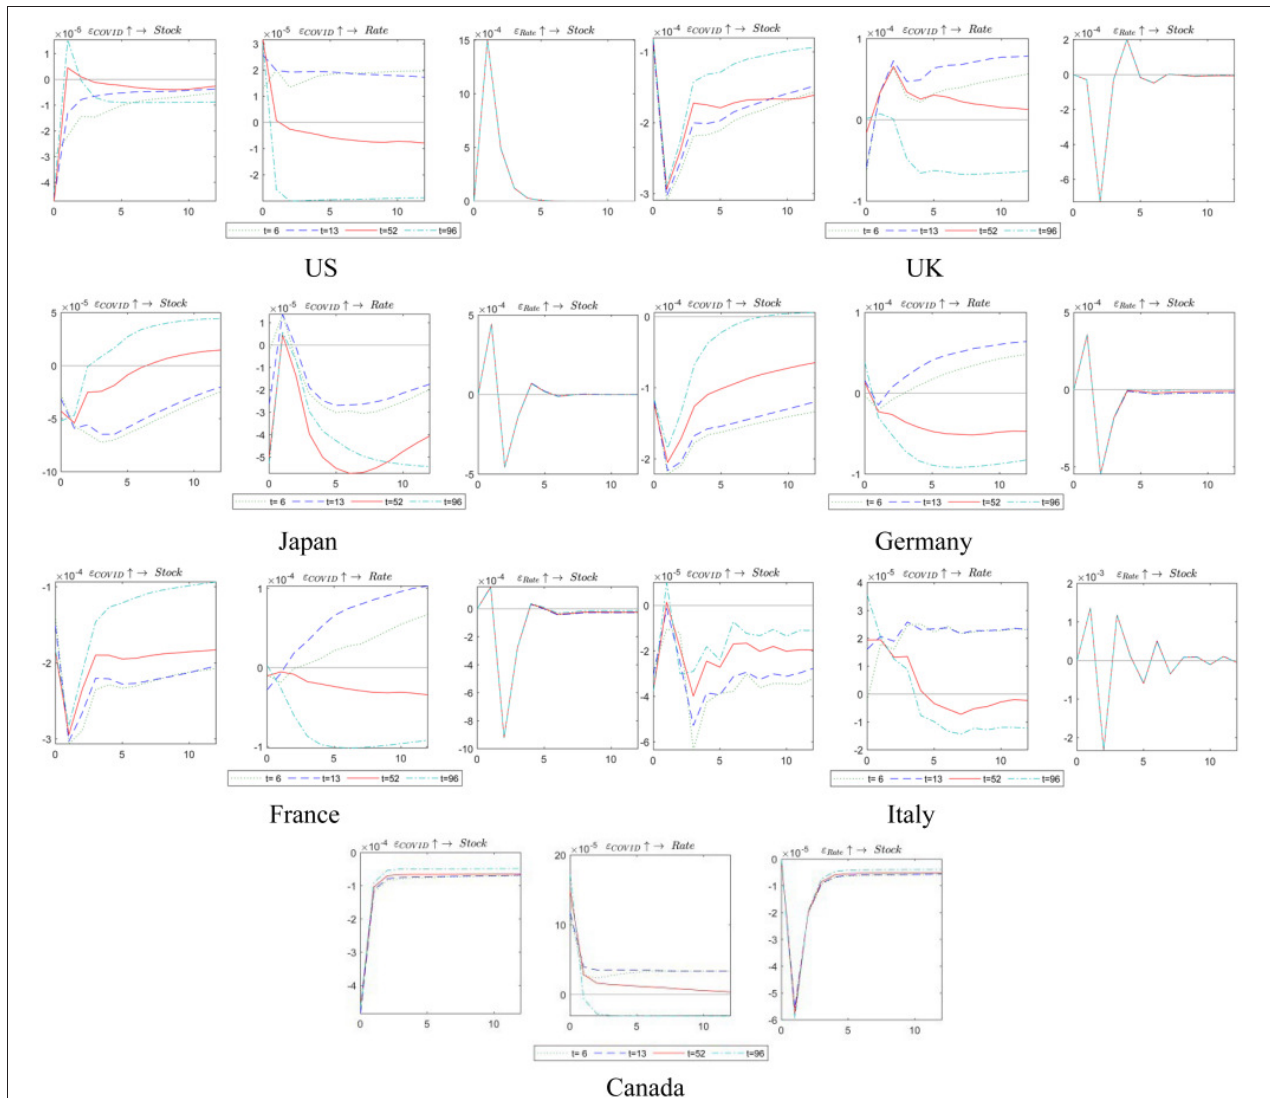
FIGURE 3 | Impulse response of stock returns to the COVID-19 epidemic at different time